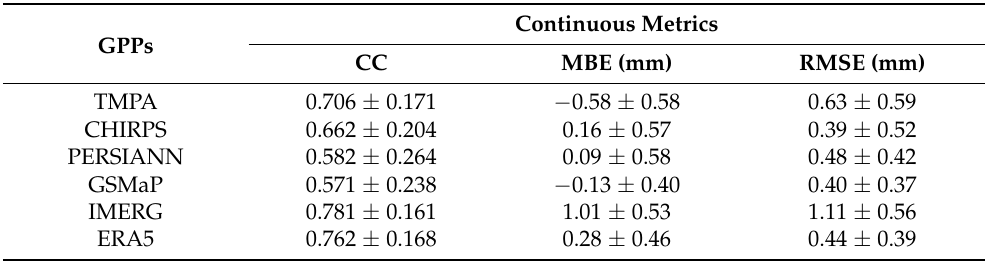
Table 6. Continuous metrics calculated from yearly average precipitations values of the GPPs and synoptic stations at the station